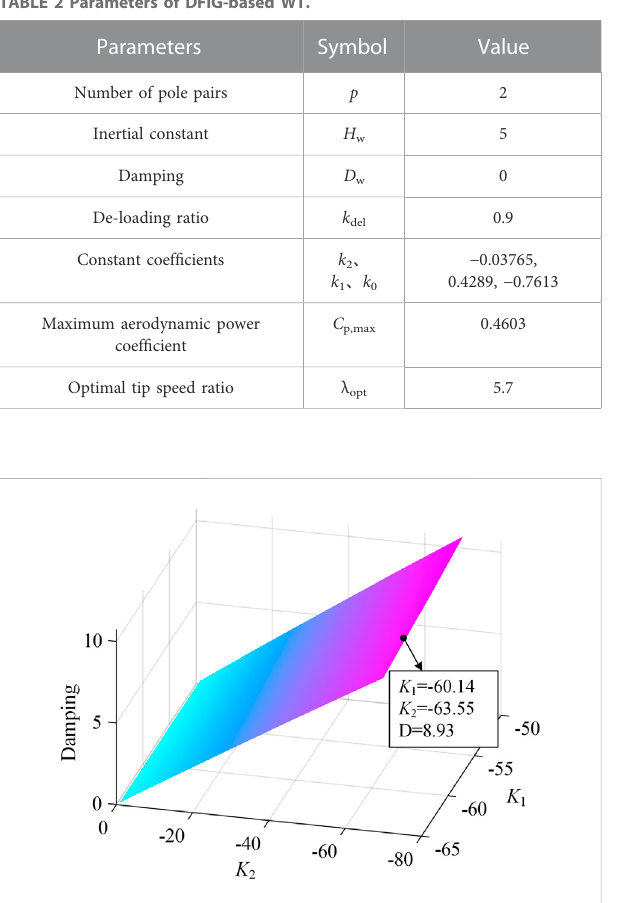
FIGURE 5 Damping under various parameters of sliding surface matrix K .